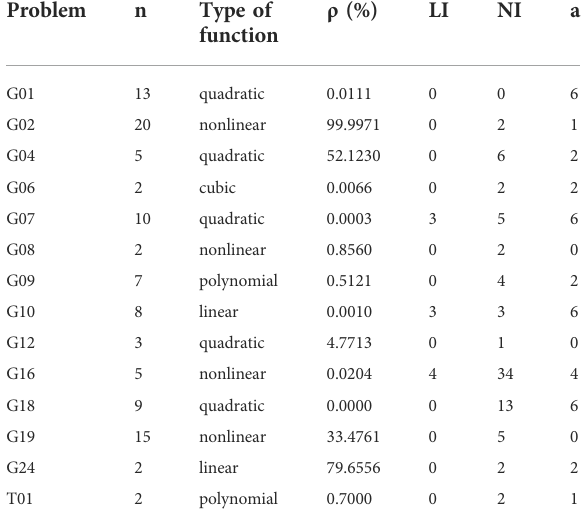
TABLE 2 Details of the test